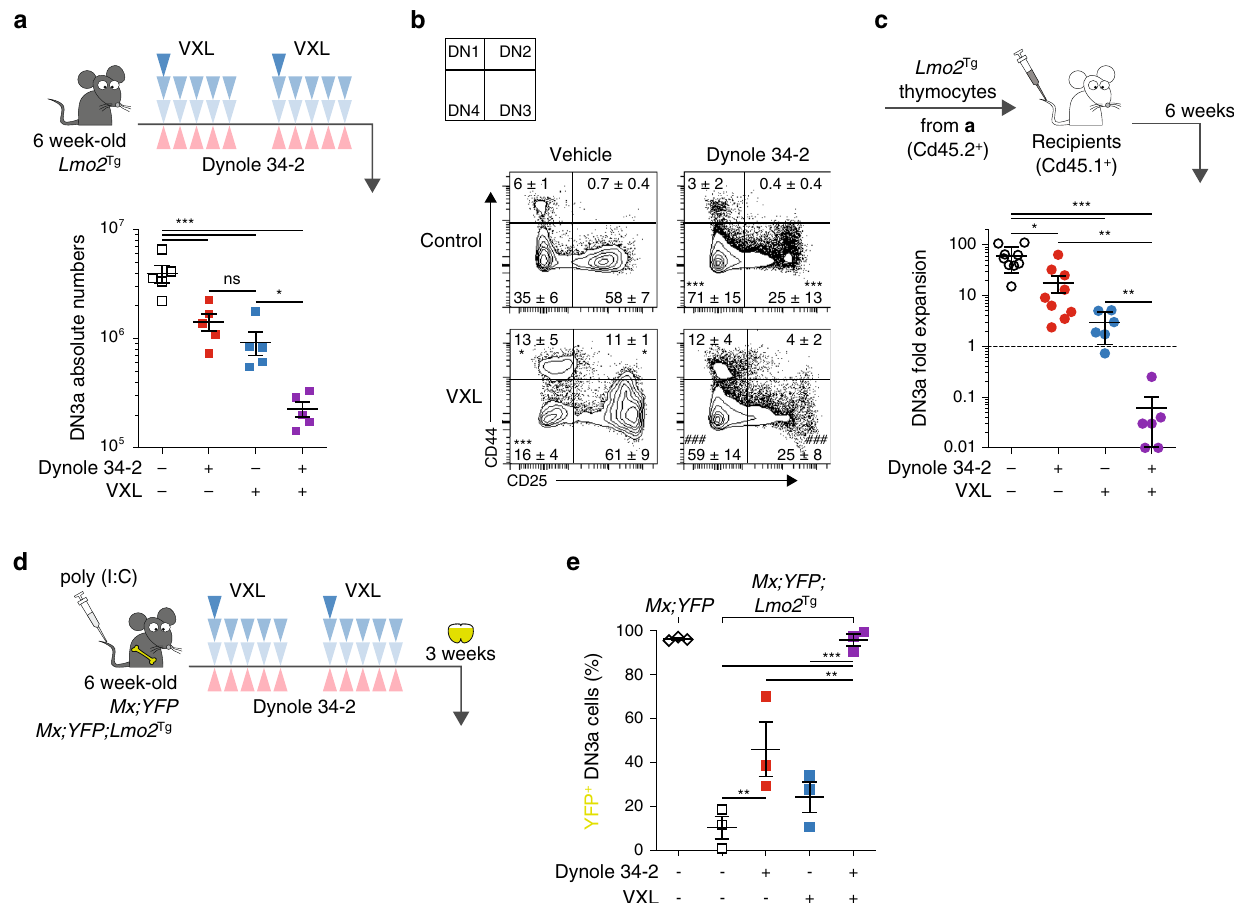
Fig. 4 Dynole 34-2 sensitizes pre-LSCs to induction-like therapy. a Treatment schematic and absolute numbers of DN3a T-cell progenitors in the thymus of 6-week-old Lmo2 Tg mice following administration of two rounds of vehicle and Dynole 34-2, alone or combined with VXL chemotherapy. Mean ± SEM, two-way ANOVA with Tukey ’ s correction test; * P < 0.05 and *** P < 0.001. Each square represents an individual animal. b Representative fl ow cytometry analysis of the CD4 − CD8 − (DN) T-cell progenitor populations in the thymus of 6-week-old Lmo2 Tg mice following administration of two rounds of vehicle and Dynole 34-2, alone or combined with VXL chemotherapy. Mean± SD ( N = 5 individual mice), two-way ANOVA with Bonferroni correction test; * P < 0.05 and *** P < 0.001 compared to vehicle; ### P < 0.001, as compared to VXL, respectively. c Fold expansion of DN3a thymocytes from Lmo2 Tg mice treated with either vehicle, Dynole 34-2, VXL or combination therapy with Dynole 34-2. Mean ± SEM, two-way ANOVA with Bonferroni correction test * P < 0.05, ** P < 0.01 and *** P < 0.001. Each circle represents an individual animal. d Scheme for the intrathymic competition assays in the Mx ; YFP and Mx ; YFP;Lmo2 Tg mice, which were injected with poly (I : C) to induce the expression of YFP in the bone marrow stem cells (HSCs), which can be tracked in the thymus 3 weeks post-injection. e Proportion of HSC-derived (%YFP + ) DN3a thymocytes in Mx ; YFP;Lmo2 Tg mice treated with vehicle, Dynole 34-2, VXL and the combination Dynole 34-2 + VXL. Mx ; YFP mice were used as positive controls. Mean± SEM ( N = 3 individual mice), two-way ANOVA with Tukey ’ s correction test; * P < 0.05, ** P < 0.01 and *** P < inhibit pathologically relevant signalling pathways in LSCs from T-ALL despite mutually exclusive activating mutations of IL-7 or Notch1.